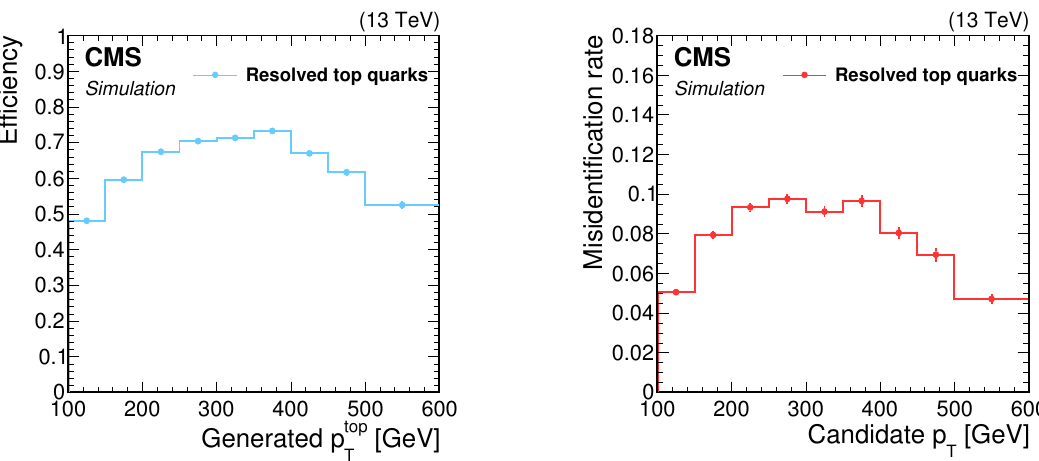
Figure 3 . Left: e(cid:14)ciency in MC simulation to identify resolved top quark decays as a function of the p T of the generated top quark. Right: misidenti(cid:12)cation rate in MC simulation as a function of the p T of resolved top quarks, in a sample dominated by the QCD multijet